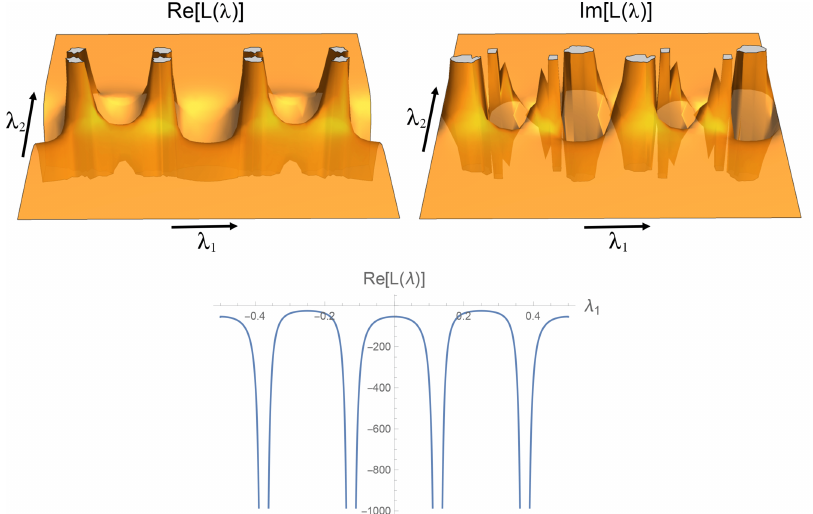
Figure 27 . Top: real (left) and imaginary (right) parts of L ( λ ) in the thermal AdS 3 phase. The metric (2.7) is singular at the values of λ corresponding to the endpoints of the slits (i.e. λ and λ = {− L/ 2 + ‘/ 2 , − ‘/ 2 , ‘/ 2 , L/ 2 − ‘/ 2 } ) for any value of z , and approaches a constant value 1 λ away from the λ = 0 slice where the measurement is performed. Bottom: real part of L ( λ ) in the 2 thermal AdS phase as a function of λ on the λ = 0 slice. The singularities at the endpoints of 3 1 2 the slits (here ‘ = s = 0 . 25 ) are well